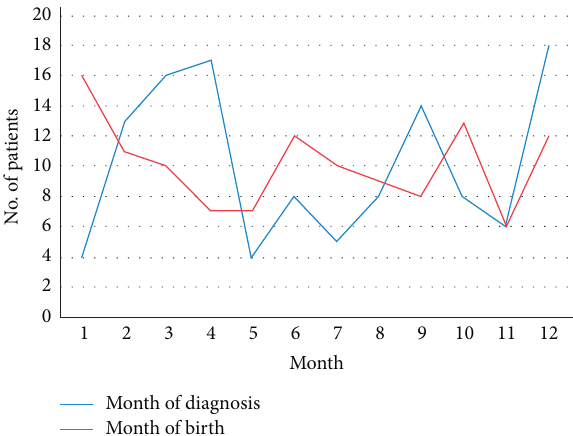
Figure 4: Number of biliary atresia by the month of birth and